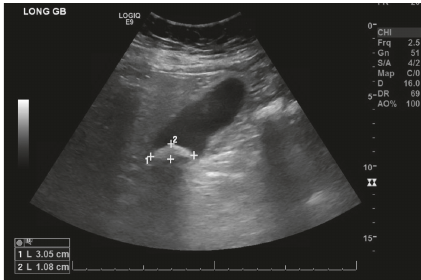
Figure 3: Preoperative HIDA scan shows normal filling.